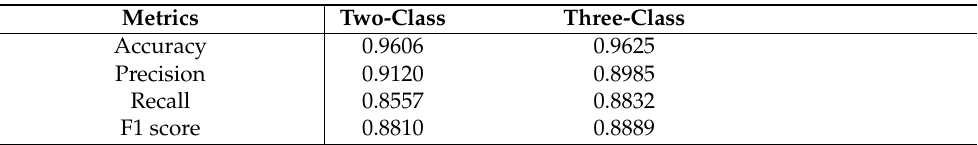
Table 4. Comparison of the two-class and three-class RF(CSI). N t and N d are 1000 and 32 in both models.